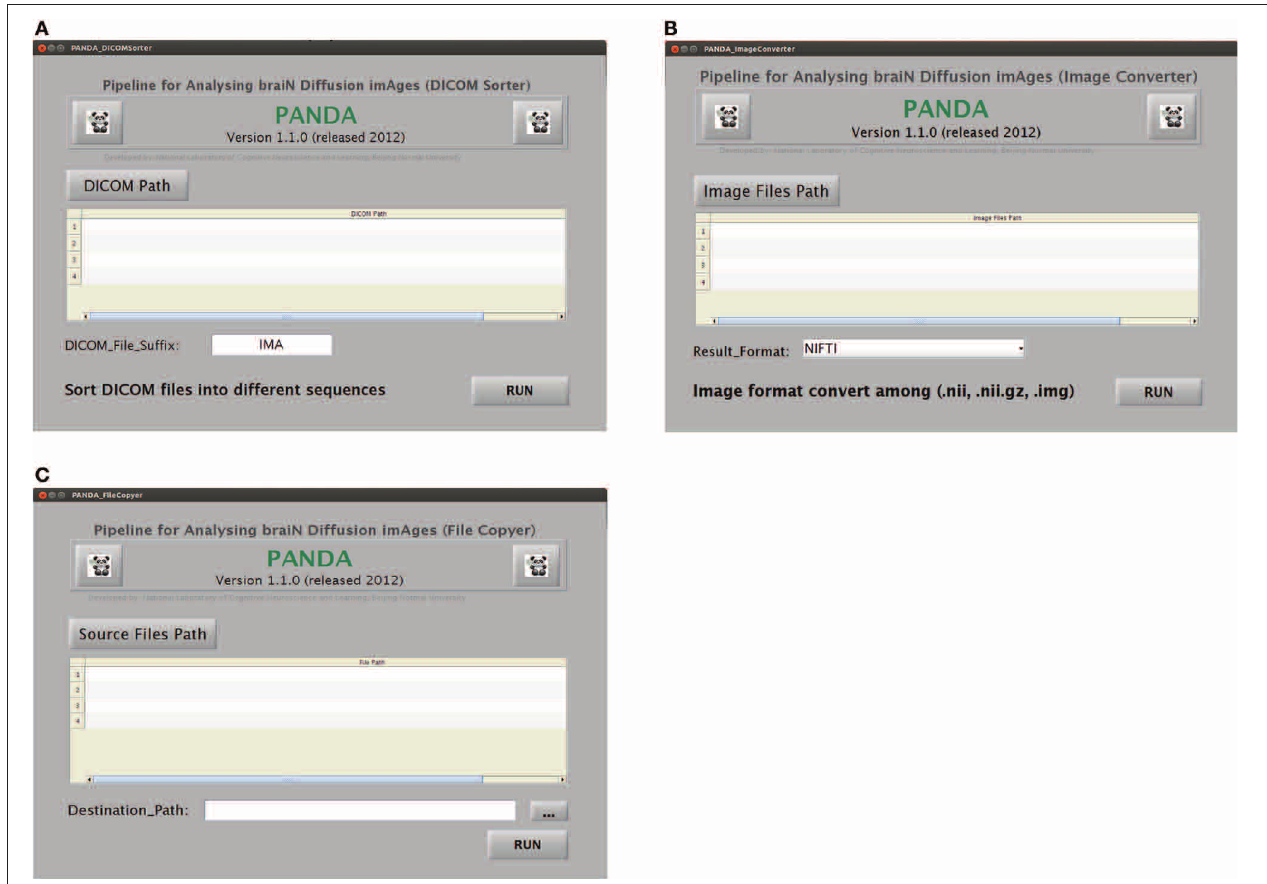
FIGURE B5 | GUIs for the utilities “DICOM Sorter,” “Image Converter,” and “File Copier” in PANDA. (A) The utility for DICOM Sorter. (B) The utility for Image Converter. (C) The utility for File